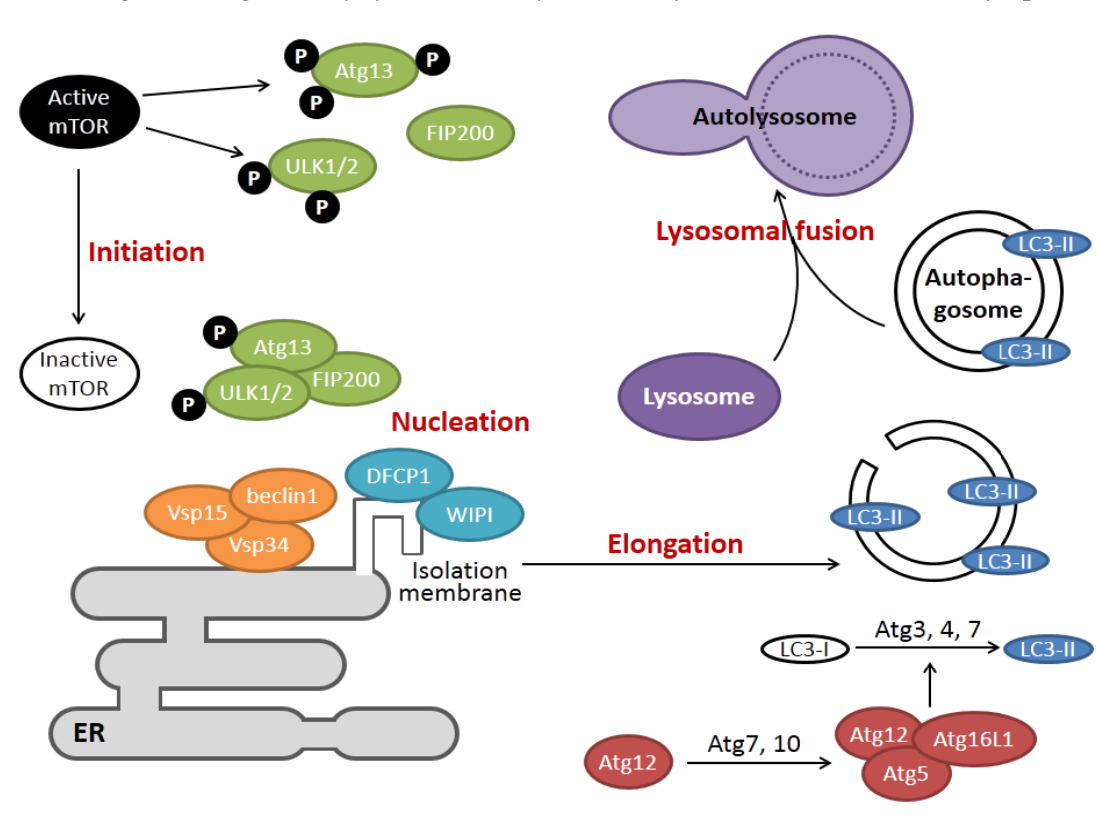
Figure 2. The key players in the four stages of cellular autophagy. During initiation, inactivation of the mammalian target of rapamycin (mTOR) kinase leads to hypo-phosphorylation of autophagy-related gene 13 (Atg13) and Unc-51-like kinase 1 and 2 (ULK1/2), allowing for the formation of the ULK complex. The ULK complex recruits the class III phosphatidylinositol-3-OH kinase (PI3K) complex (coiled-coil, myosin-like Bcl2 interacting protein 1 (beclin1)-vacuolar protein sorting 15 (Vsp15)-Vsp34) at the nucleation sites in the ER, where it induces the formation of isolation membrane via the activities of double FYVE domain-containing protein 1 (DFCP1) and WD-repeat protein interacting with phosphoinositides (WIPI). The elongation of isolation membrane requires the function of two ubiquitin-like systems, which results in the lipidation and conjugation of microtubule-associated proteins 1A/1B light chain 3C (LC3)-II to the autophagosome. Finally, the autophagosome fuses with lysosome to form autolysosome, and the cargos are degraded and